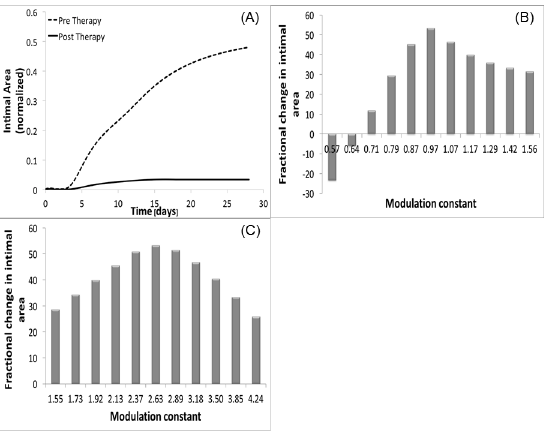
Fig 14. Gene therapy: Coupled cluster modulation. Reduction of intimal thickness recordedby modulating cluster C and D simultaneously (A), with sensitivity analysisassociatedfor cluster C (B) and cluster D (C).